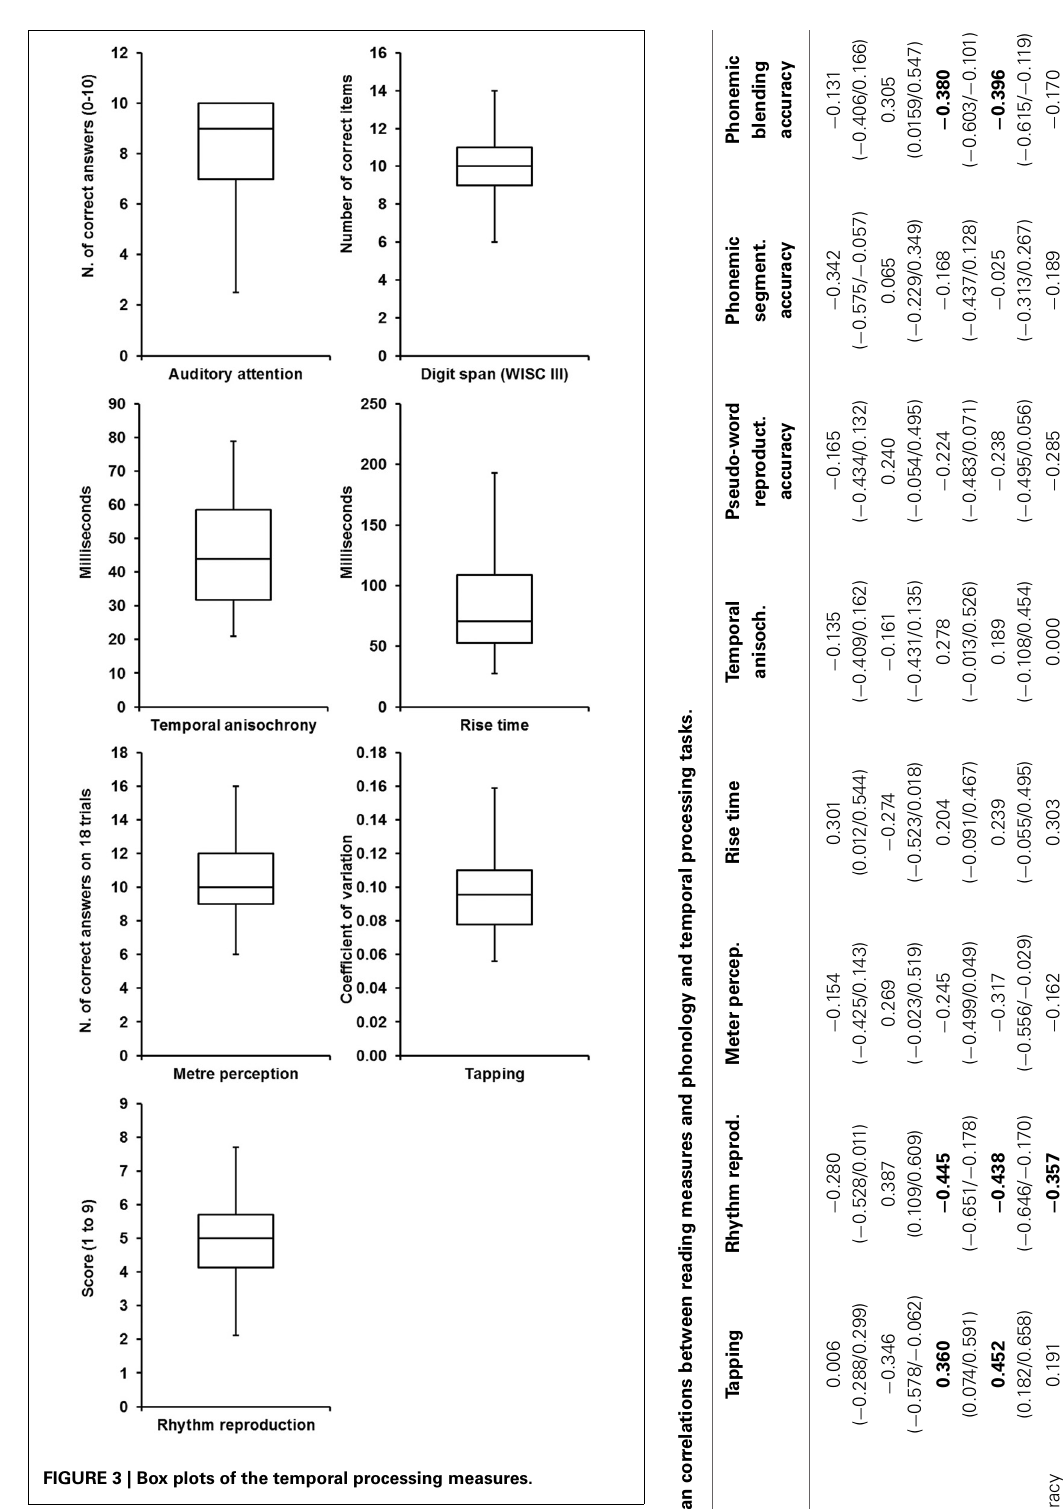
number of factors (software package F A C T O R, Unrestricted Factor Analysis 9.2 by Urbano Lorenzo-Seva and Pere J. Ferrando) and the eigenvalue criterion ≥ 1, three factors were extracted explaining a variance of 61.389% ( Table 4